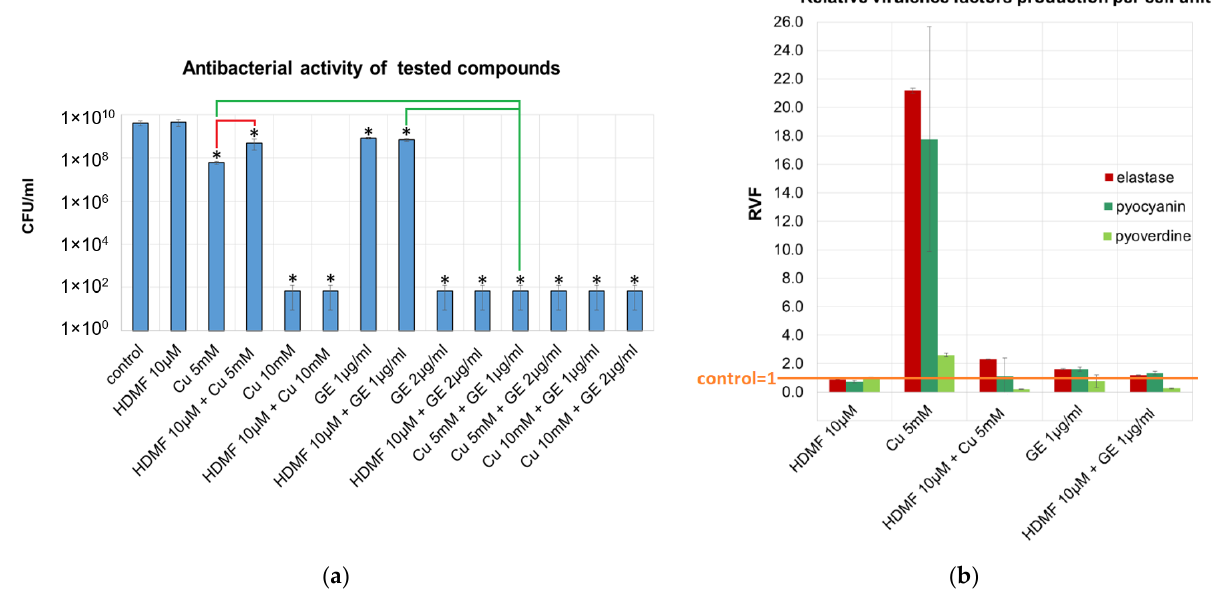
Figure 1. The impact of Cu 2+ , HDMF, and GE on P. aeruginosa PAO1 growth rate and virulence determinant production: ( a ) colony count after 20 h of incubation; ( b ) relative virulence factor production (RVF) per cell unit compared to the untreated control; *statistically significant differences according to PAO1 control ( p < 0.05), brackets indicate statistically significant differences between agent combinations ( p < 0.05).